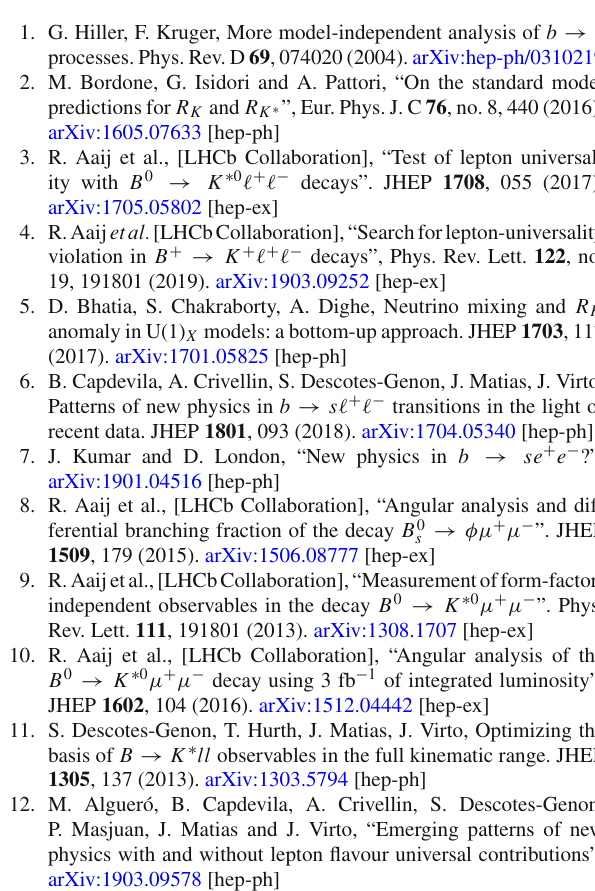
Fig. 10 Comparison of allowed NP parameter space using D 0 - neutrino trident